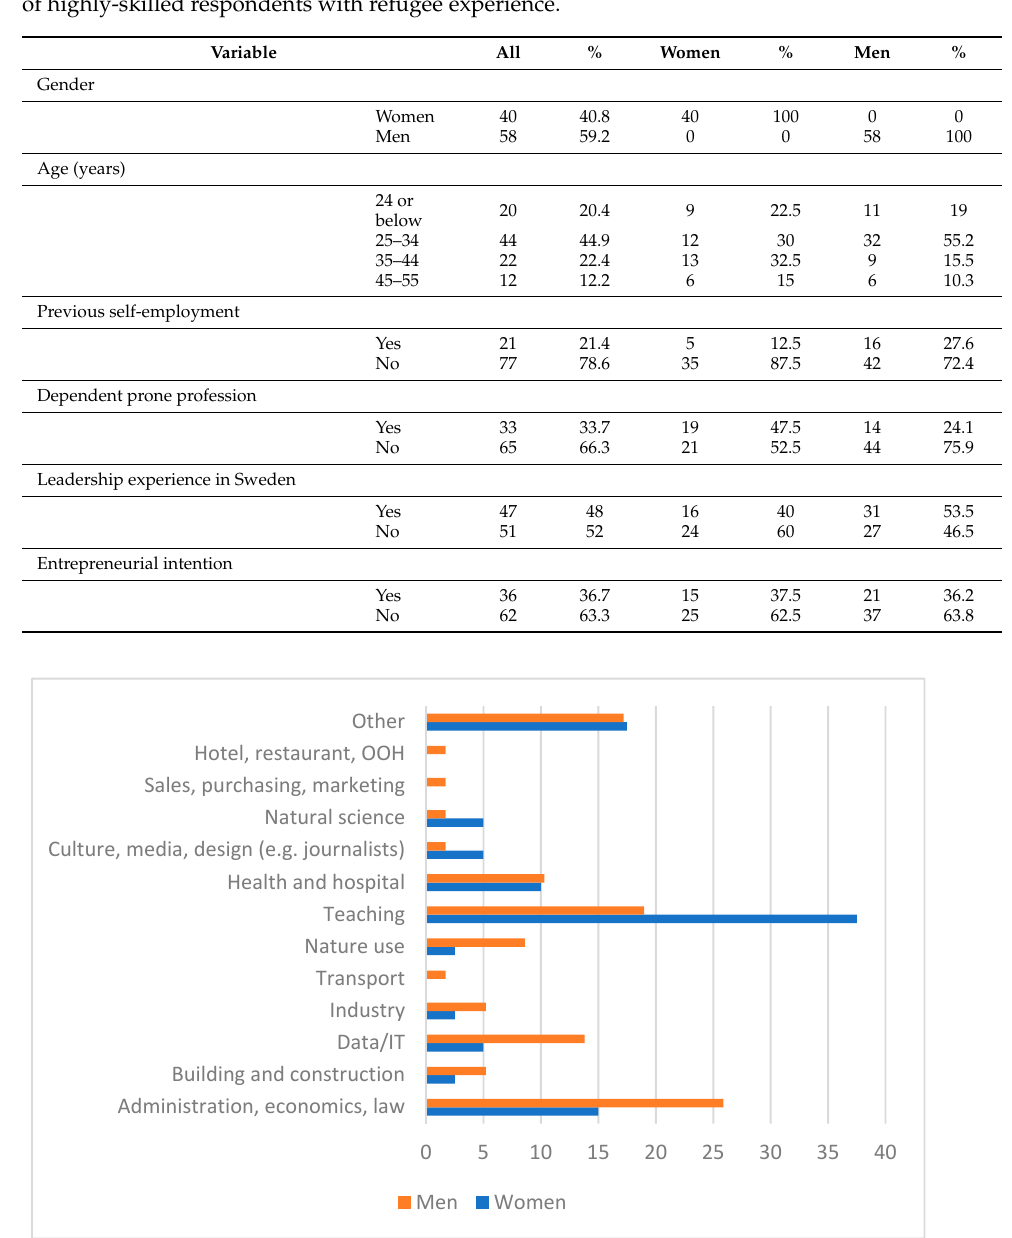
Figure 1. Educational background of highly-skilled men and women ( N = 98) with refugee experience before coming to Sweden.